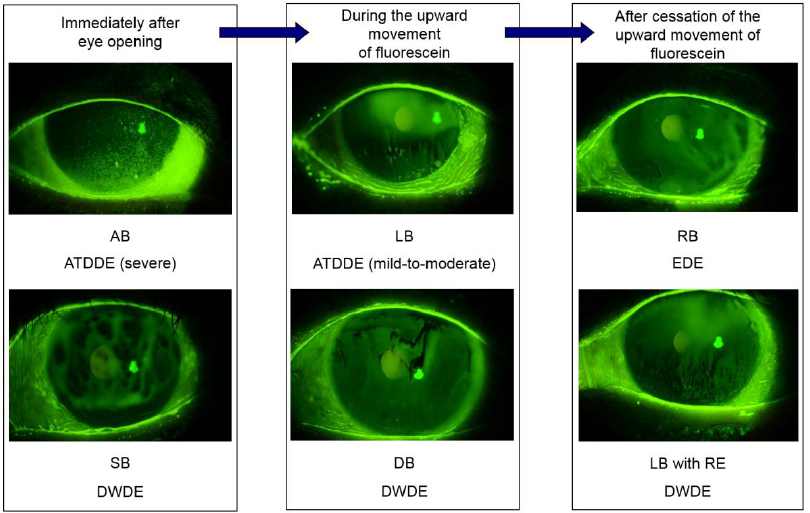
Figure 1. Fluorescein breakup (BU) patterns seen immediately after eye opening and after the eye is kept open. Related to the establishment of the tear film (TF) on the cornea, there are three phases for each fluorescein breakup pattern that can be seen. In the first phase, an area break (AB) or a spot break (SB), respectively, can be seen in cases of severe aqueous tear deficient dry eye (ATDDE) or decreased wettability dry eye (DWDE). In the second phase, a line break (LB) or a dimple break (DB), respectively, can be seen in cases with mild-to-moderate ATDDE or DWDE. In the third phase,